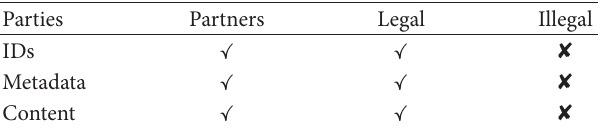
Table 1: Security specifications. Table 2: Security and privacy specifications.